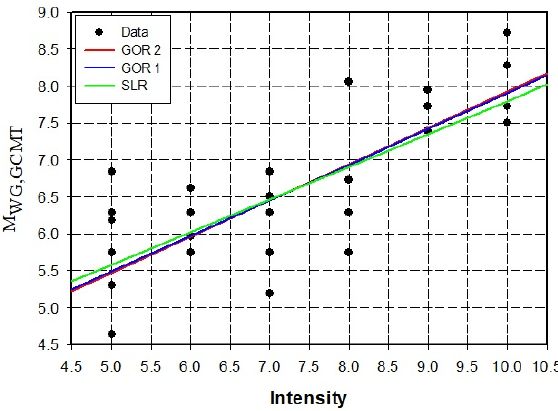
Figure 14. Comparison of the uncertainty in regression parameters for (M D – M wg ) data pairs using GOR1, GOR2, and SLR approaches considering function of error variance ratio: ( a ) Correlation Co- efficient determination (R xy ), ( b ) Root mean square error (RMSE), ( c ) uncertainty values of slope and ( d ) uncertainty of intercept.